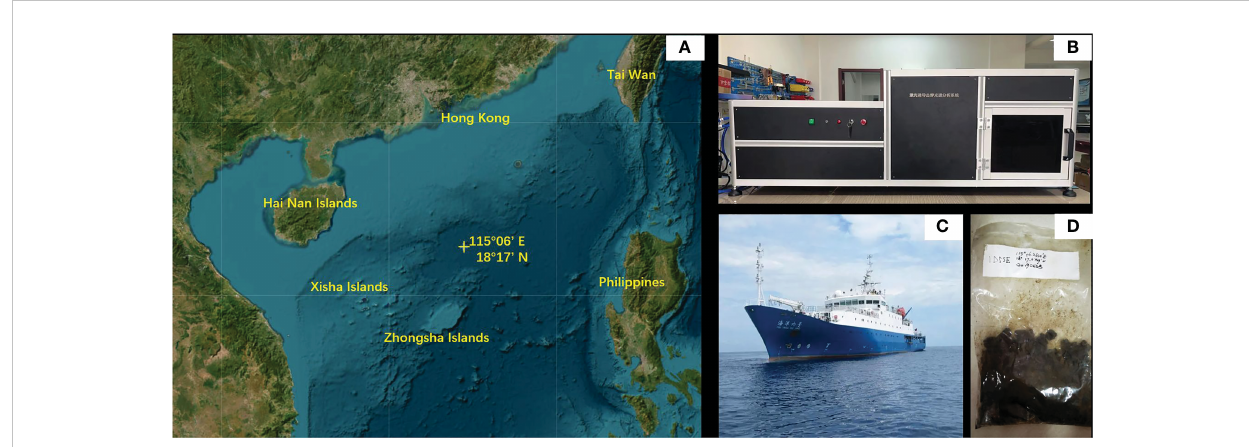
FIGURE 2 (A) The deep-ocean geological survey region of the South China Sea; (B) the LIBS measuring system with the implementation of packaging and integration; (C) the Hai Yang 6 Hao ocean survey ship; (D) the seabed mineral sample mined by a deep-ocean mining vehicle at a water depth of 2,490